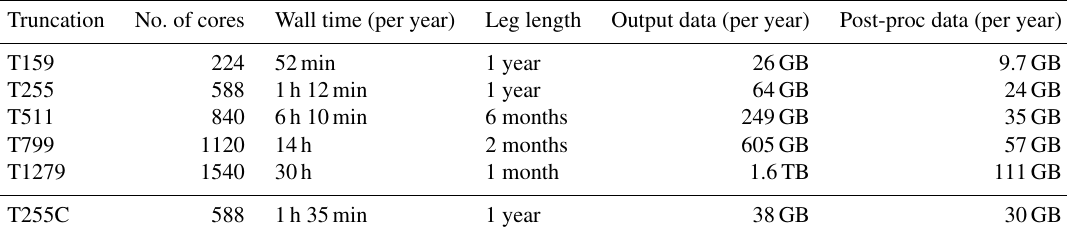
Figure 3. (a) Time series for 45 ◦ S–45 ◦ N yearly averaged SST for present-day HadISST 2.1.1 (red), FutureHadISST 2.1.1 (violet) and CMIP5 EC-Earth ensemble mean (light blue). (b) Time series for Northern Hemisphere (filled circles) and Southern Hemisphere (empty circles) yearly averaged sea ice area for HadISST 2.1.1 (dark blue), FutureHadISST 2.1.1 (green), CMIP5 EC-Earth ensemble member “r8i1p1” (light blue) and the CMIP5 EC-Earth ensemble mean (faint blue). Table 3. Resolution-dependent technical details for EC-Earth in the Climate SPHINX experiments. T255C is the coupled configuration used for PFC simulations. Wall time has been measured on the Supermuc-II Haswell platform, and it is evaluated for deterministic simulations; stochastic simulations wall time is about the 5%